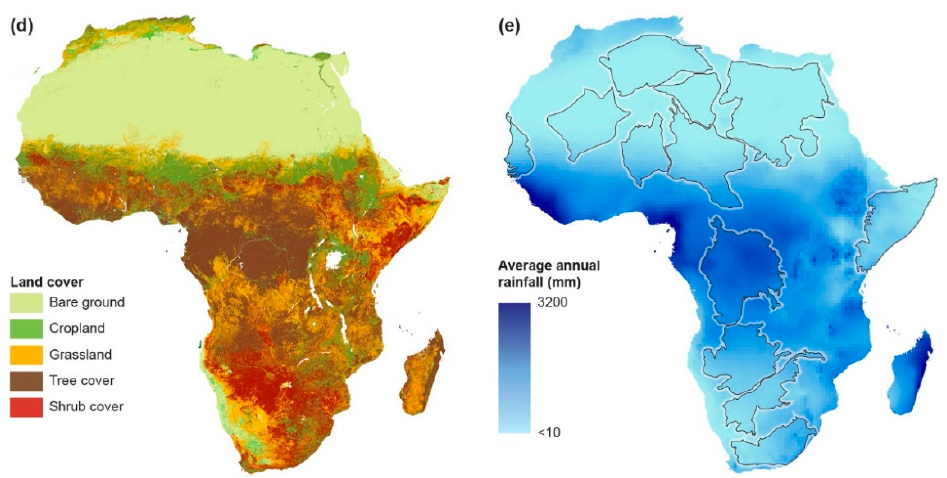
Figure 1. A series of groundwater maps for Africa: ( a ) the hydrogeological environments for Africa [41], in which the sedimentary environments are divided in terms of groundwater storage and flow; ( b ) estimated groundwater storage in Africa, based on effective porosity and thickness of the aquifers [16]; ( c ) the average seasonal terrestrial water storage changes indicated by Gravity Recovery and Climate Experiment (GRACE) at a continental-scale across Africa, with the major sedimentary aquifer basin boundaries (to which the GRACE, rainfall and land surface model (LSM) data are extracted) highlighted in black; ( d ) land cover; and ( e ) average annual rainfall.